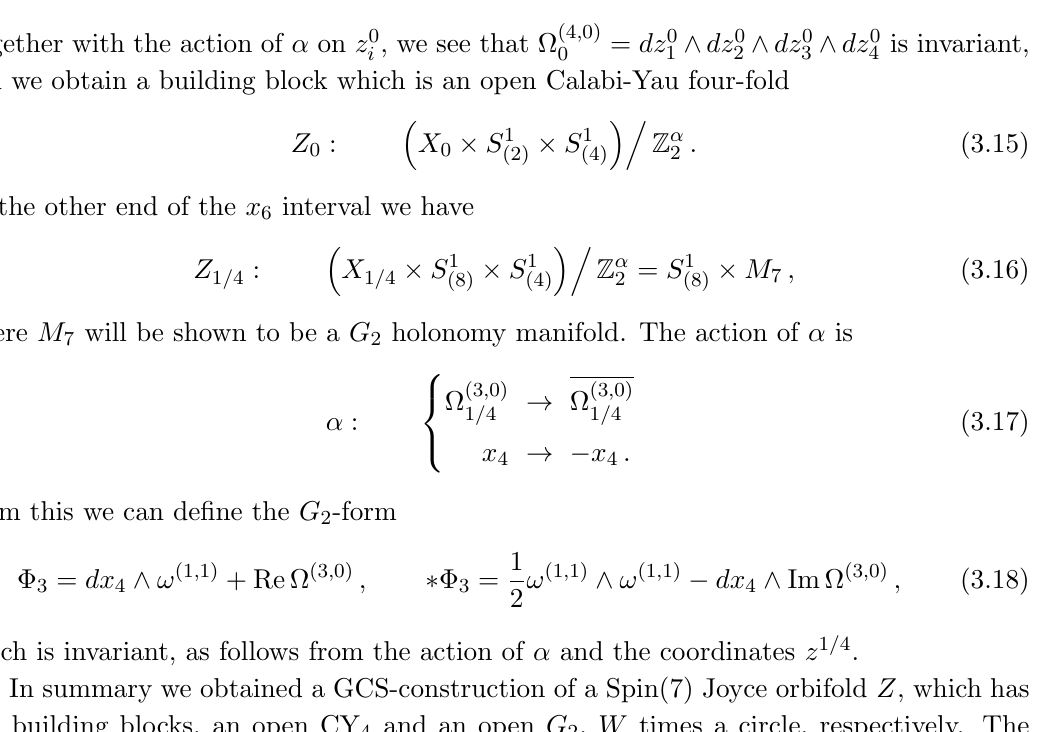
Figure 4 . The GCS decomposition of the Spin(7) Joyce orbifold: the building blocks are Z 0 and Z , which are an open Calabi-Yau four-fold and an open G 2 -manifold times S 1 1 = 4 together along the x 6 coordinate. Both asymptote to X s times a cylinder, where X s is the Schoen Calabi-Yau three-fold. In this particular example each building block contains a K3, which is also present in the neck region of the Schoen